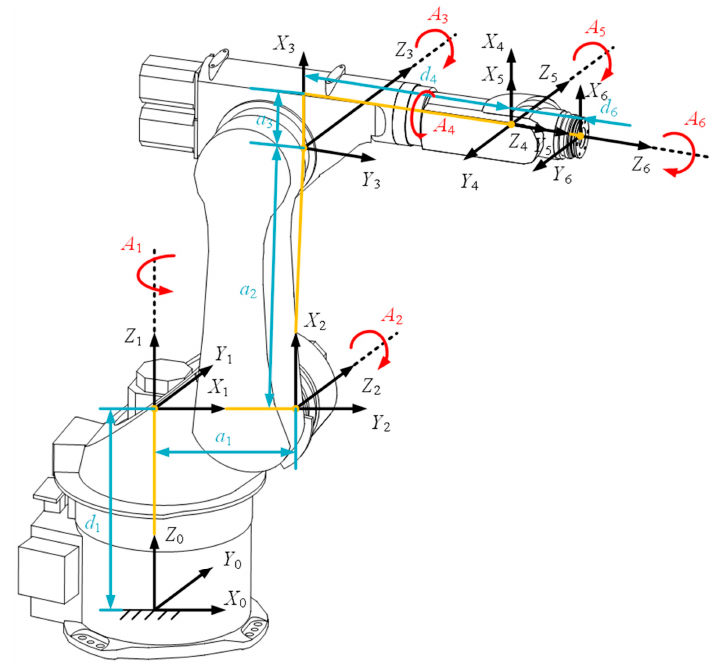
Figure 1. Link frames of KUKA KR60-3. Table 1. DHm parameterization of KUKA KR60-3.